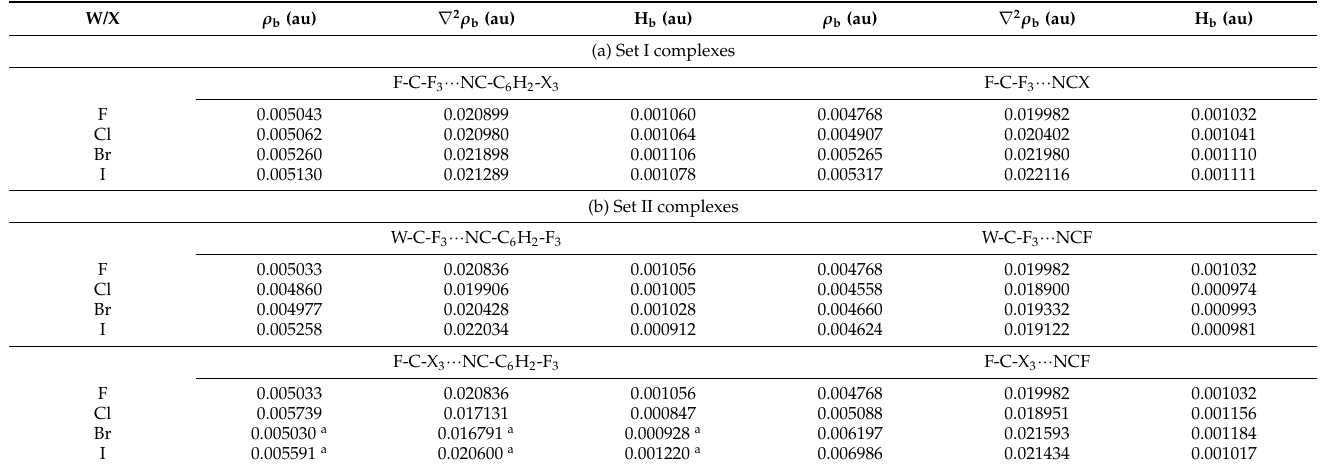
Figure 5. QTAIM diagrams of ( a ) Set I and ( b ) Set II complexes. Red dots point out the BCPs locations within the interacting species. Table 3. Topological parameters, comprising ρ b , ∇ 2 ρ b , and H b (in au), for (a) Set I and (b) Set II complexes.